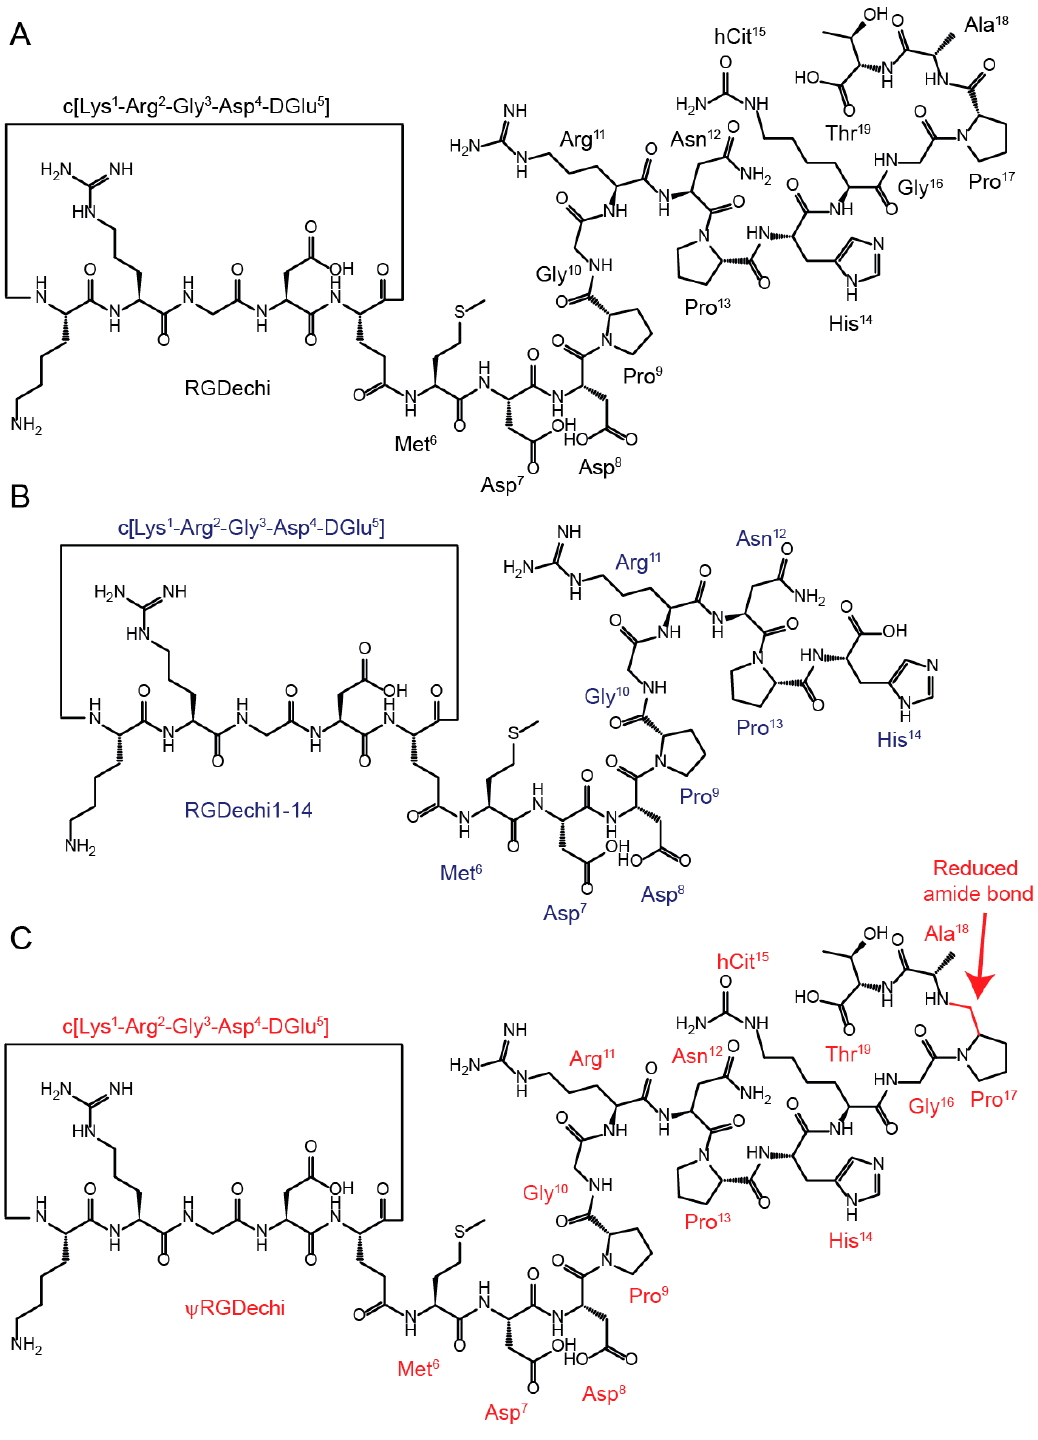
Figure 1. Chemical structure of RGDechi ( A ) and its two derivatives RGDechi1-14 ( B ) and ψ RGDechi ( C ).